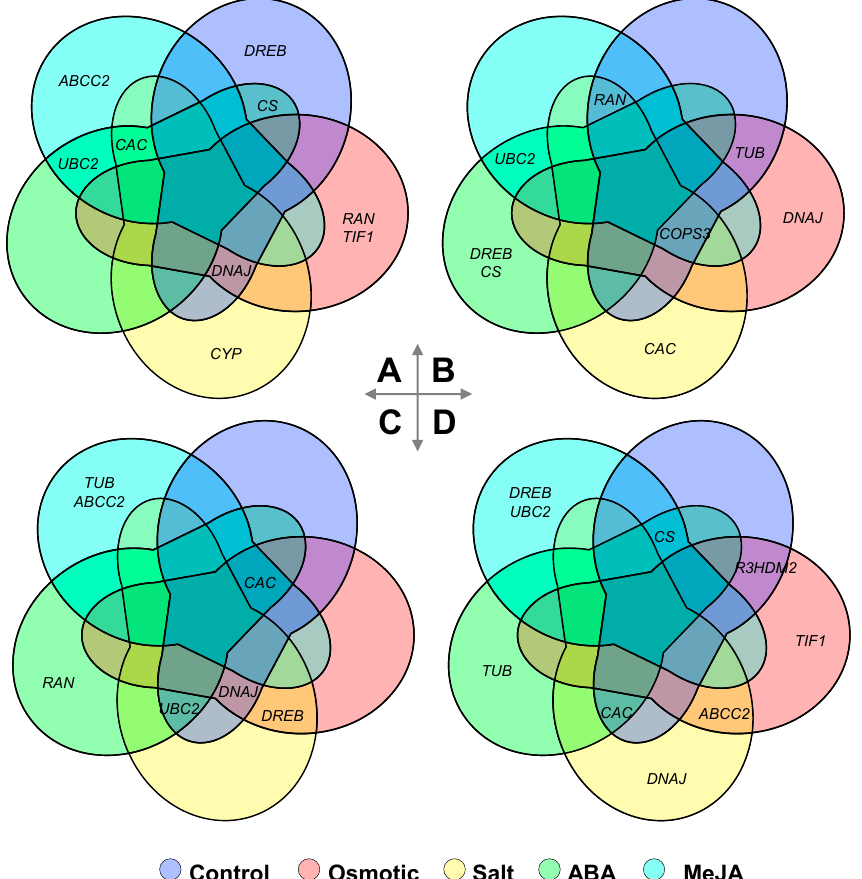
Figure 4. Comparison of the optimal reference genes under different experimental conditions between G. urelensis and G. inflata : the Venn diagram compares the top three most suited reference genes under different experimental conditions in the leaf ( A,B ) or root ( C,D ) between the congeneric G. uralensis and G. inflate , respectively.